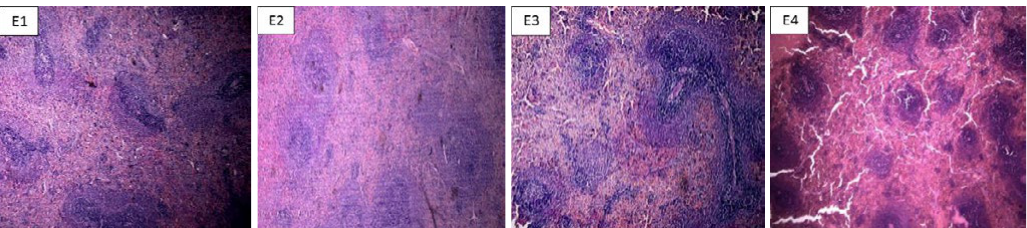
Fig. 6. Photomicrographs of spleen sections obtained from rats exposed to different concentrations of IONs. (E2, E3, E4) control rats received 50, 500, 5000 mg/kg of IONs, respectively (E1, E2, E3, E4): normal spleen, (Staining with hematoxylin and eosin). Magnification: 40 x for panels.